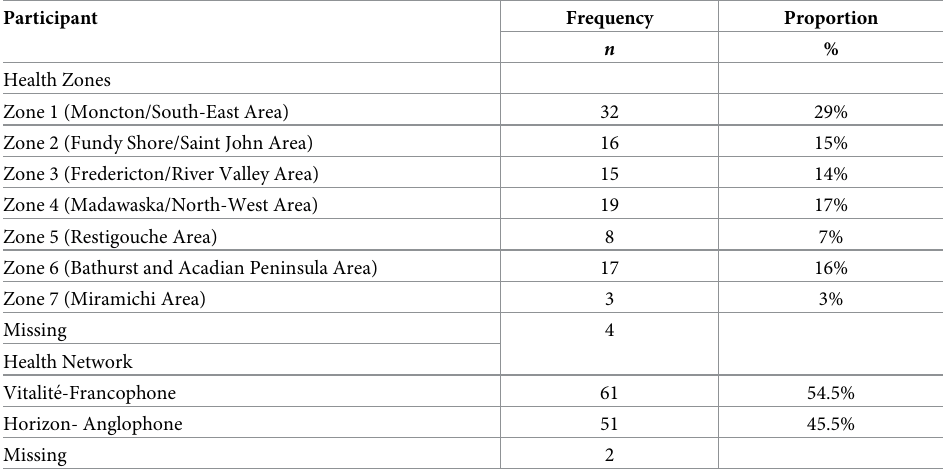
Table 1. Participants’ geographical region and affiliated health